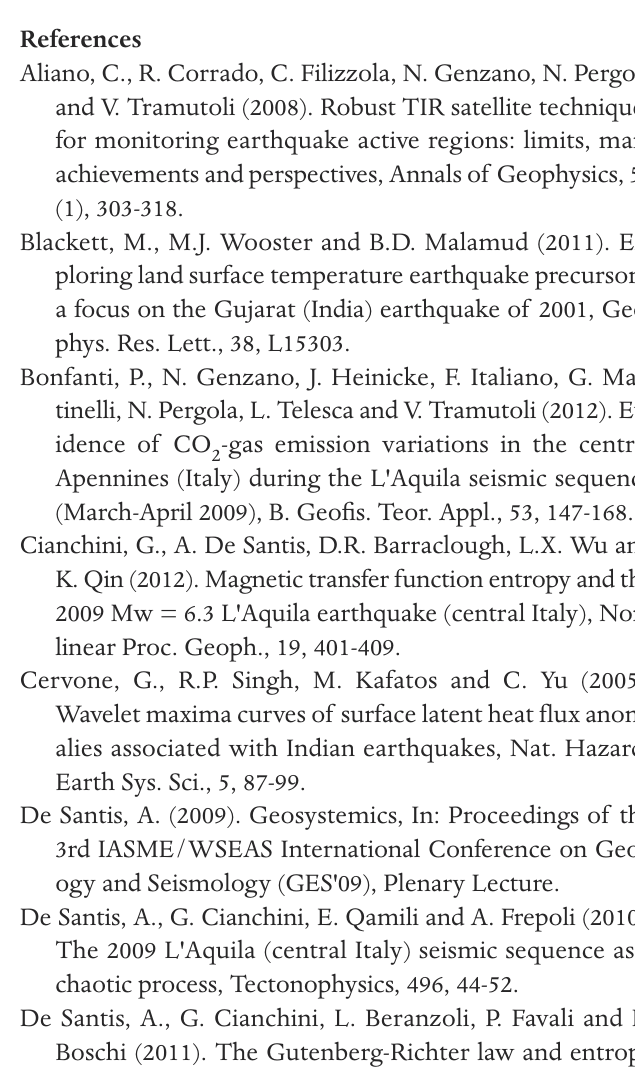
Figure 3. The spatial distribution of the change in hourly temperature ( D T ( h )) at 20-23 UTC, May 12, 2012, and at 21-23 UTC, May 24, 2012, respectively. This was obtained by subtracting the 33-year (1979-2011) mean of the corresponding hourly temperatures, which represent the climatological back- ground, from the corresponding hourly temperatures ( T ( h )) of